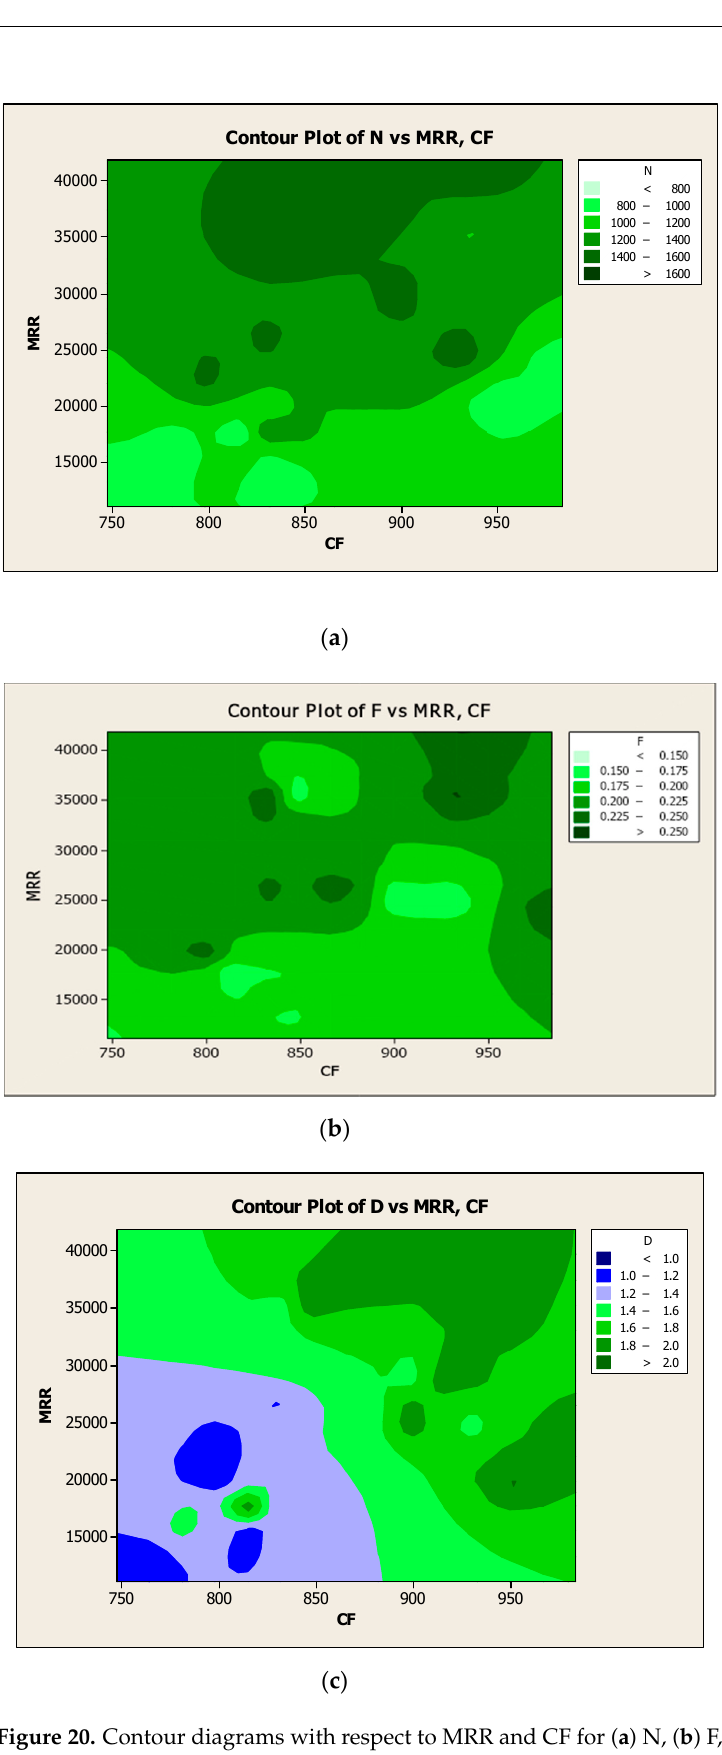
Figure 20. Contour diagrams with respect to MRR and CF for ( a ) N, ( b ) F, and ( c ) D.